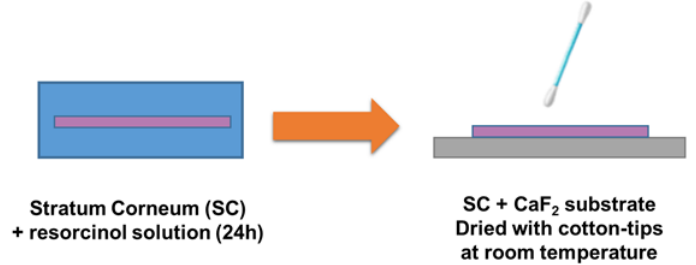
Figure 1. Procedure for infusion of SC samples in resorcinol solutions.